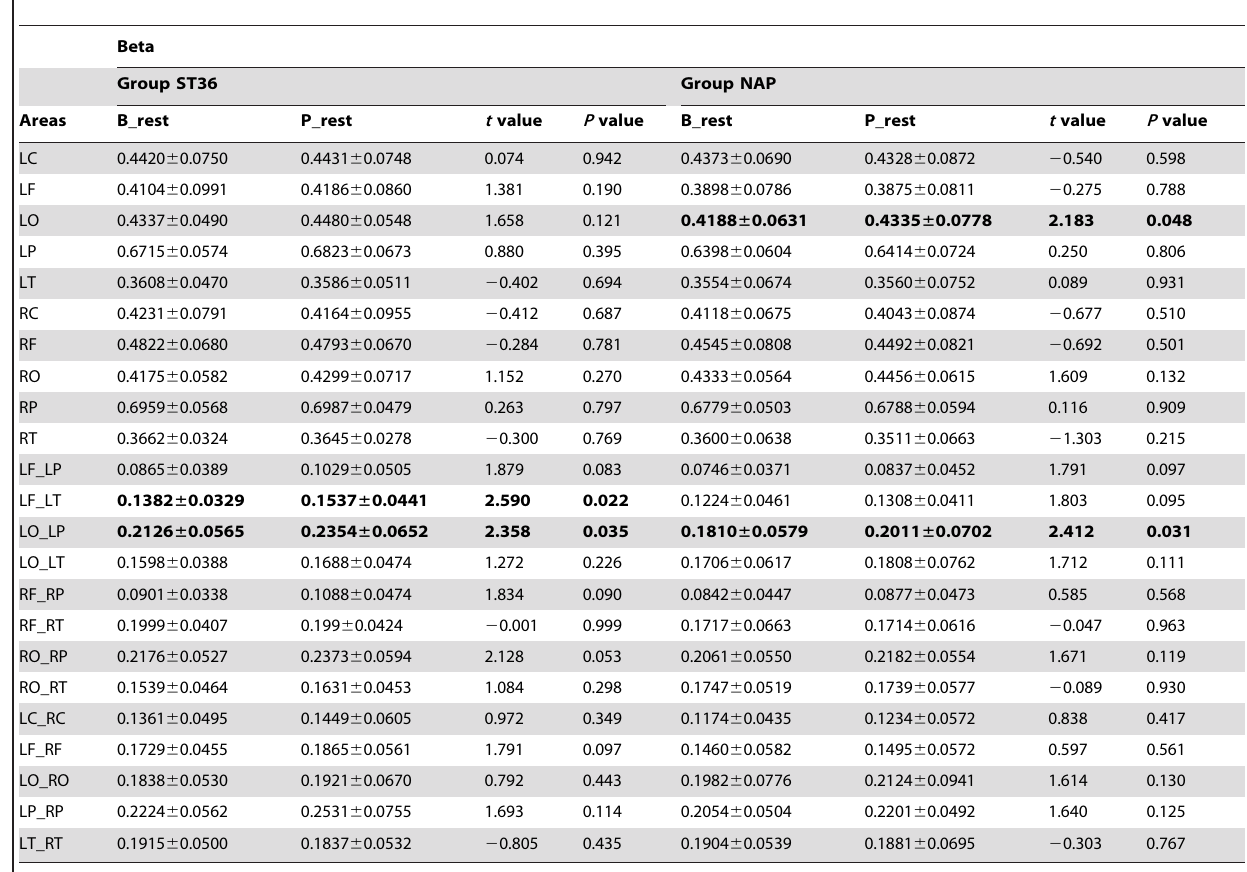
Table 2. Functional connectivity within and between main regions and statistical results in the beta bands for the ST36 and NAP groups.